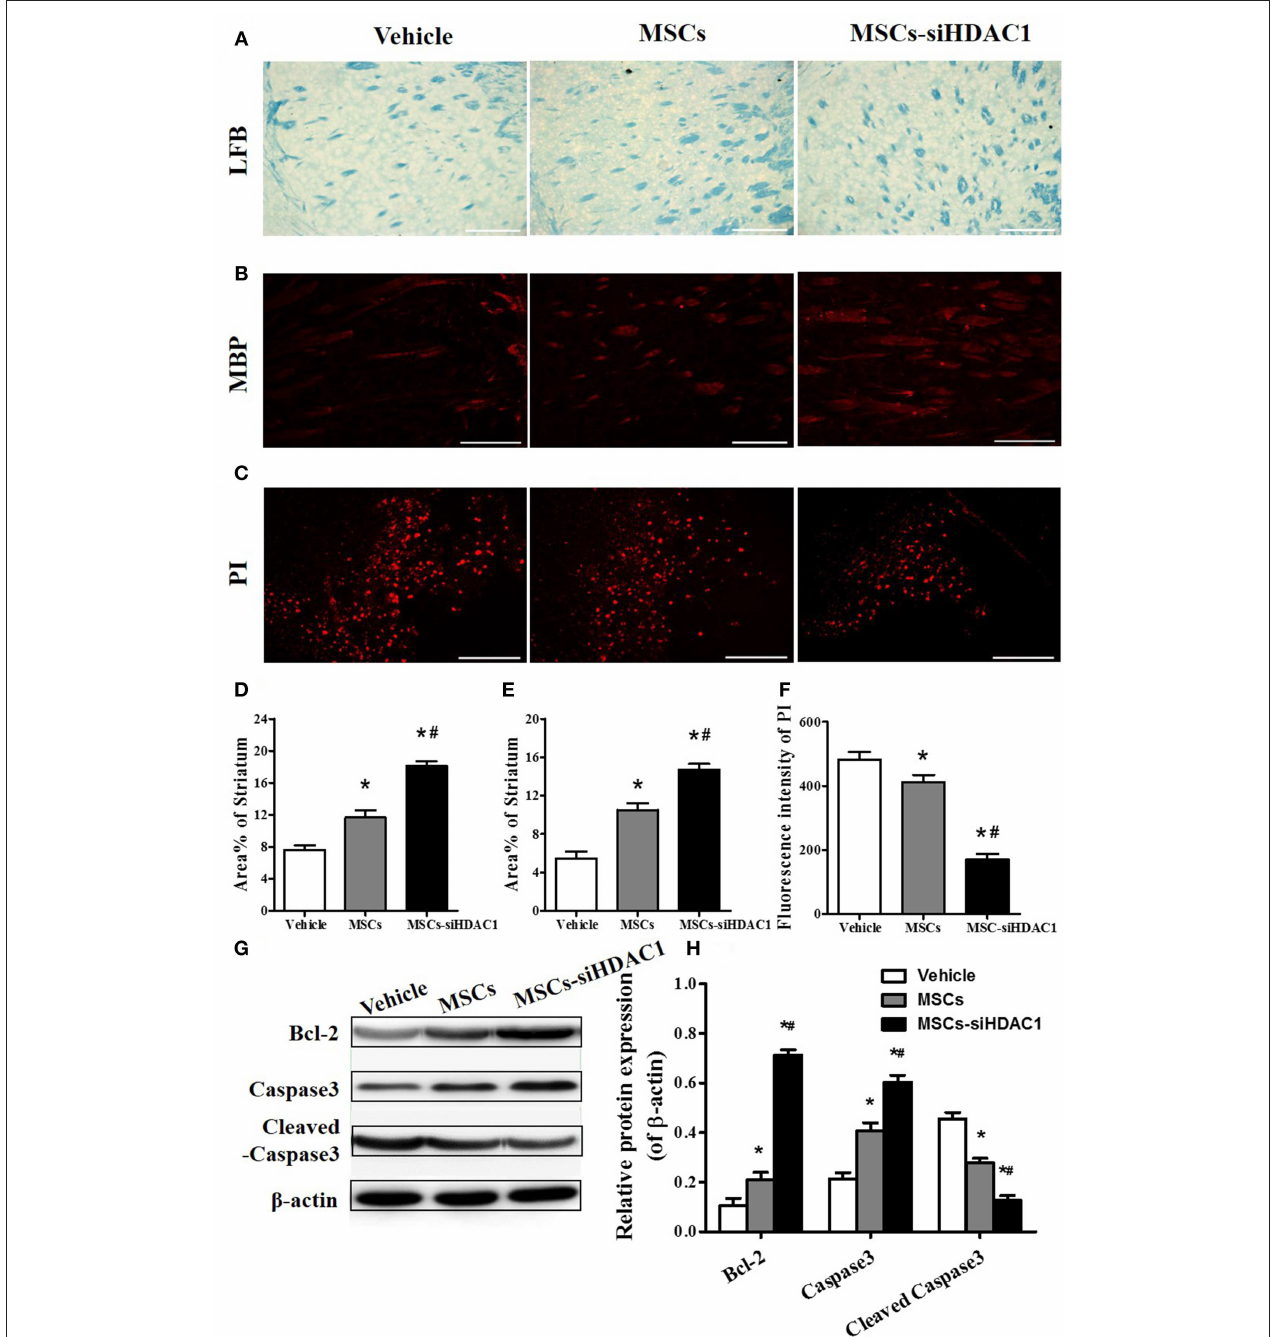
FIGURE 5 | HDAC1-silenced MSCs alleviated white matter injury and reduced cell death after TBI. (A) Representative images of luxol fast blue (LFB) staining. Scale bars = 100 µ m. (B) Myelin basic protein (MBP) staining (red). Scale bars = 200 µ m. (C) Representative propidium iodide (PI) staining (red) at 3 days after TBI. Scale bars = 100 µ m. (D) Average area of LFB at 28 days after TBI. (E) Average area of MBP. (F) Quantitative analysis of PI fluorescence intensity in the injured cortex. (G) Western blotting and (H) densitometry measurement of Bcl-2, Caspase 3, and Cleaved caspase 3 in the lesion boundary zone of each group at 3 days post-injury. Data are presented as mean ± SEM. * p < 0.05 vs. Vehicle, # p < 0.05 vs. MSCs.